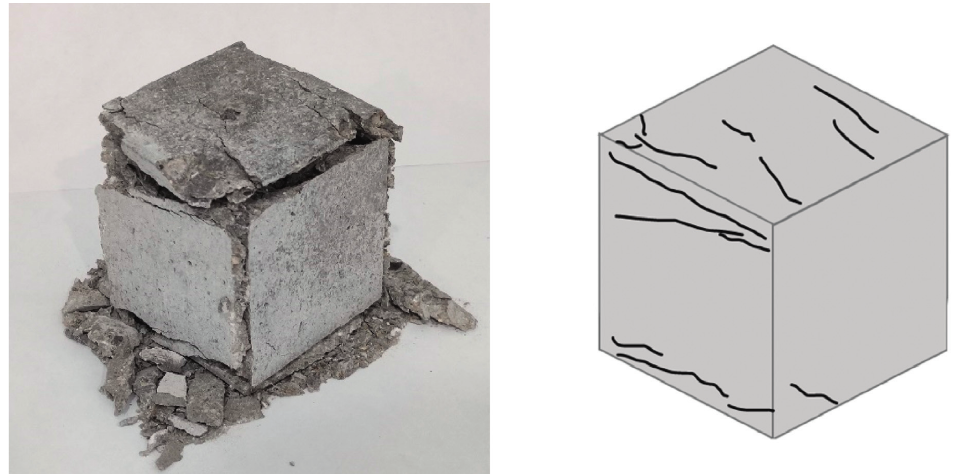
Figure 15: Typical failure modes and crack characteristics of concrete under triaxial static compression.